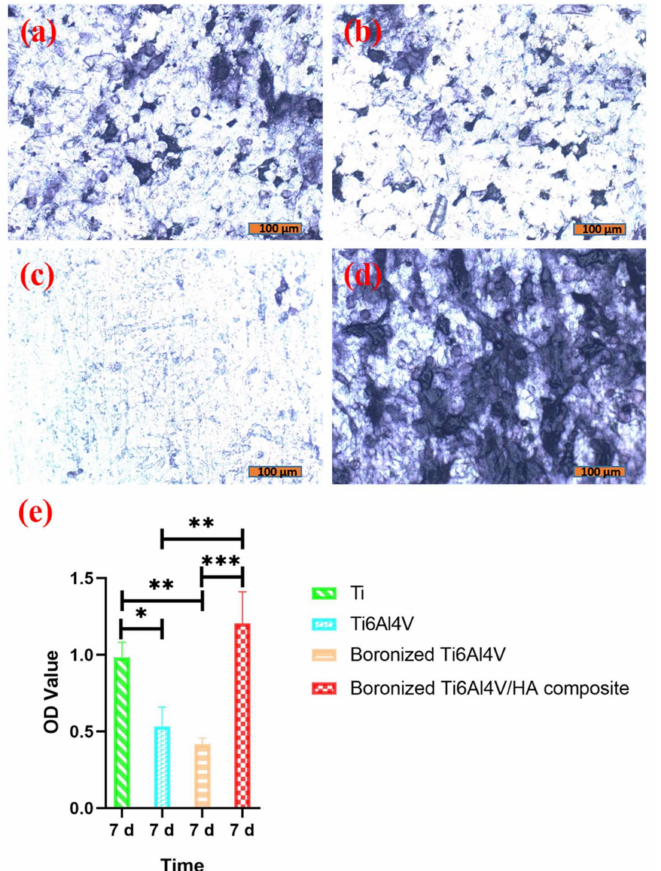
Figure 4. ALP staining of cells cultured on the different specimens for 7 days: ( a ) Ti, ( b ) Ti6Al4V, ( c ) boronized Ti6Al4V, and ( d ) boronized Ti6Al4V/HA composite. ( e ) ALP activity of cells cultured on the different specimens for 7 days (* p < 0.05, ** p < 0.01, and *** p <